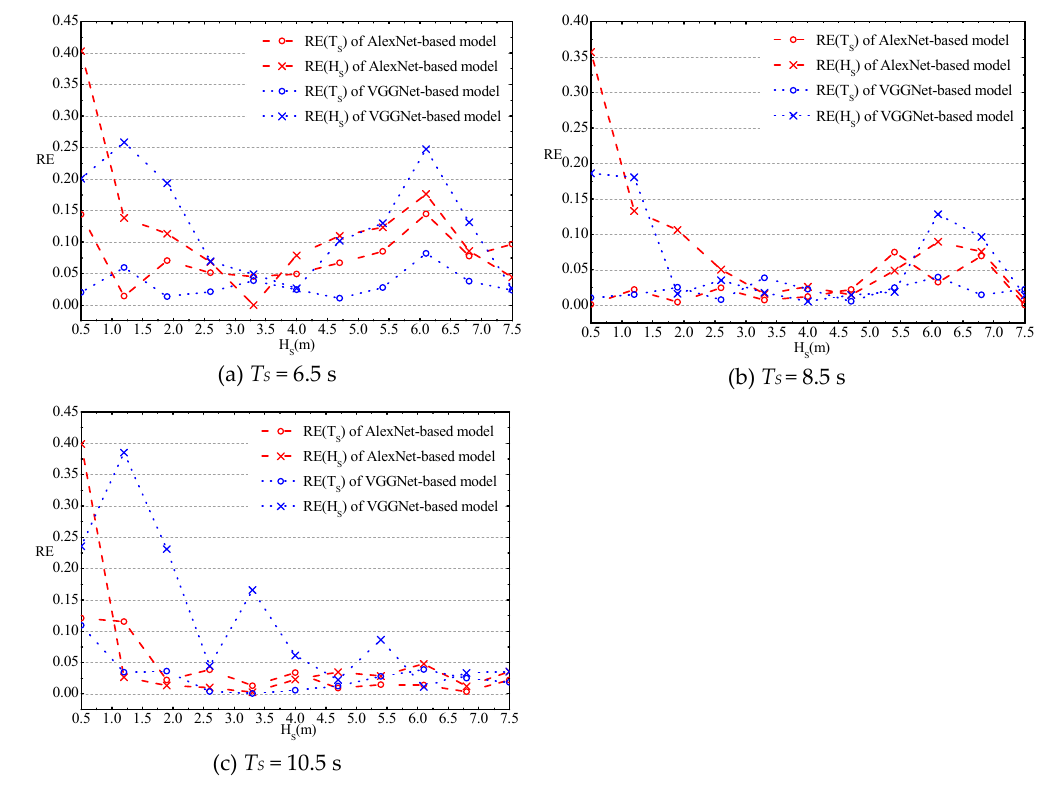
Figure 14. Change of RE with H S for different T S. In Figure 14, blue and red lines with circles represent RE( T S ) of the two CNN-based models. Generally, these lines change irregularly. For the inversion RE( H S ), however, which are represented by the red and blue lines with crosses, it decreased with the increase of H S . The RE( H S ) was large